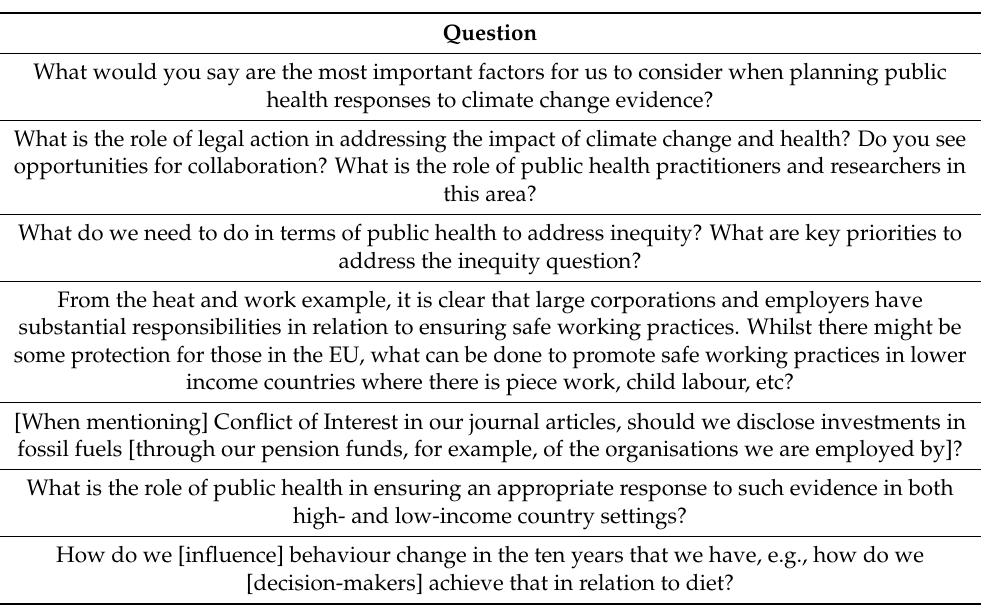
Table 1. Specific questions addressed during the workshop’s panel